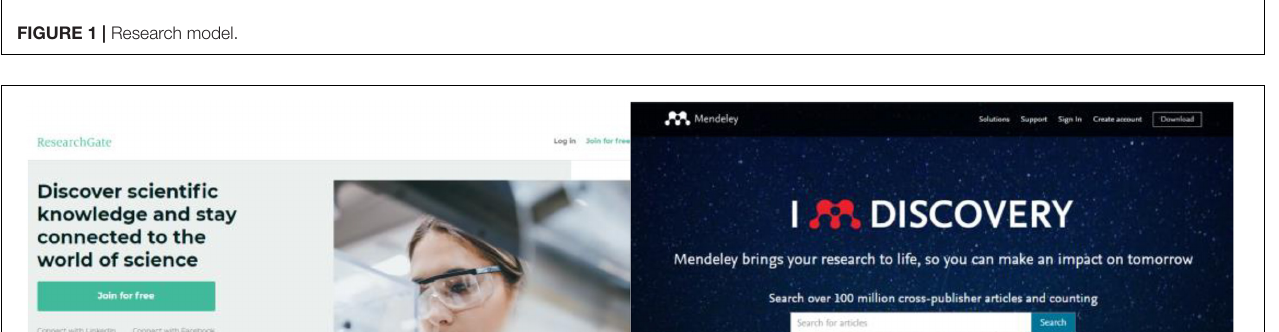
FIGURE 1 | Research model.